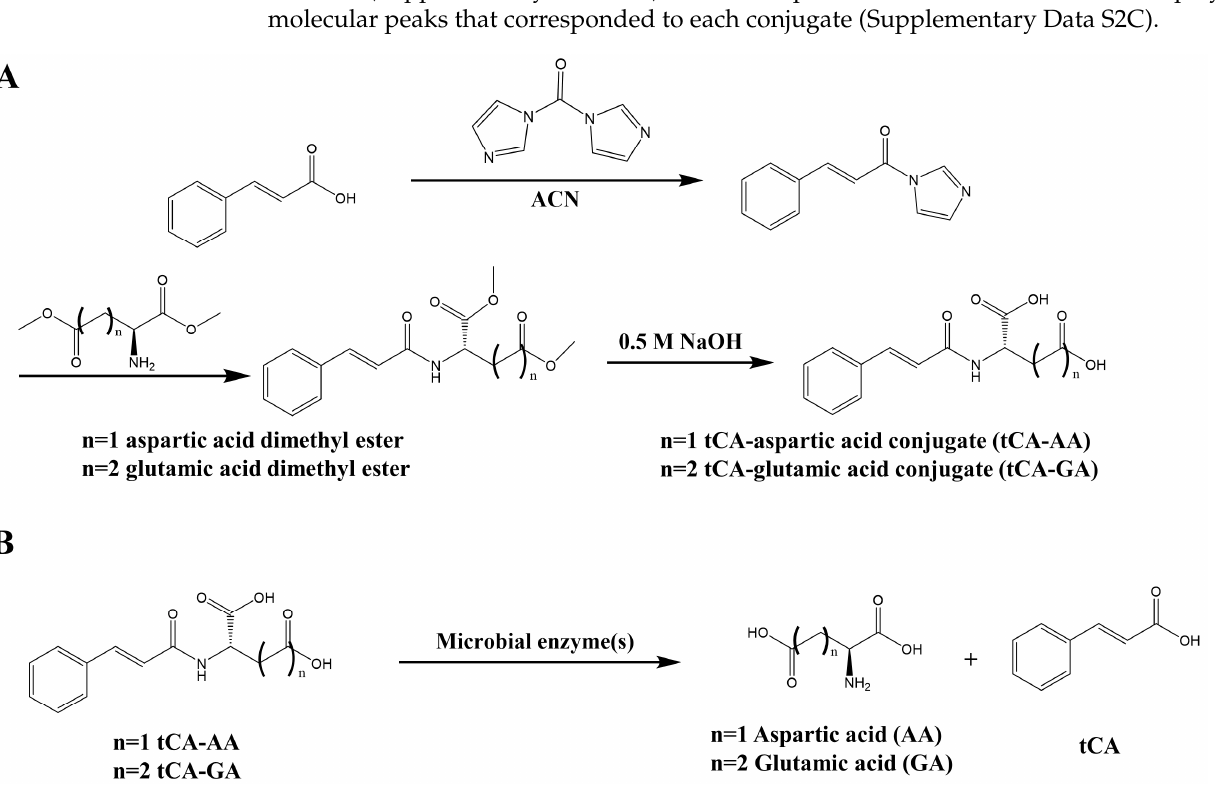
Figure 1. Synthesis of tCA-GA and tCA-AA and the colonic activation of the conjugates. ( A ) Synthetic scheme of tCA-GA and tCA-AA; ( B ) proposed scheme for the colonic activation of the conjugates.